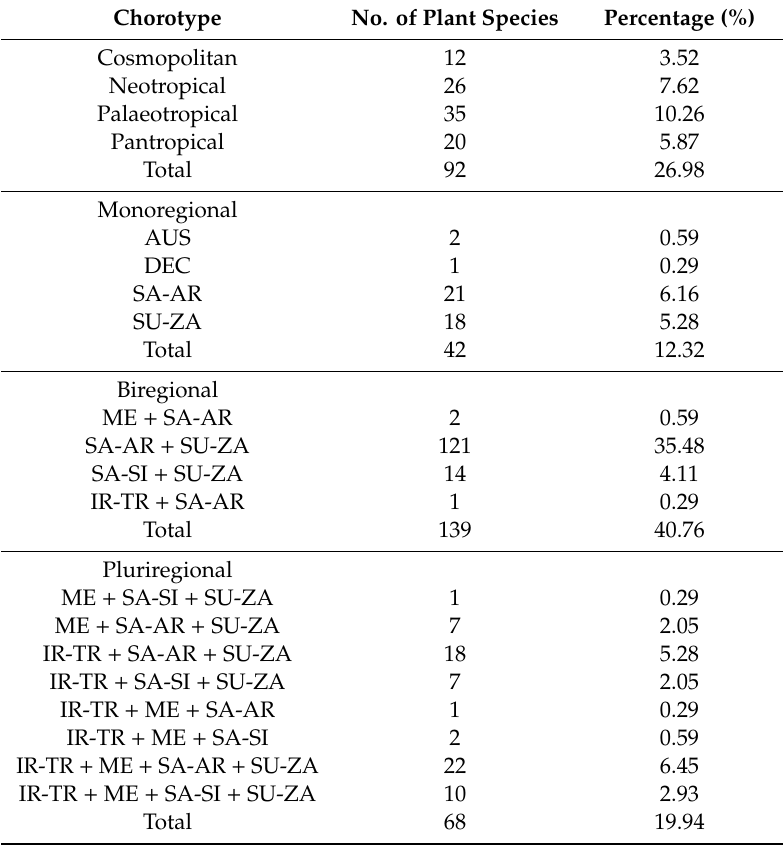
Table 2. Numbers of plant species belonging to the main floristic chorotypes and their relevant percent (%) recorded in Jabal